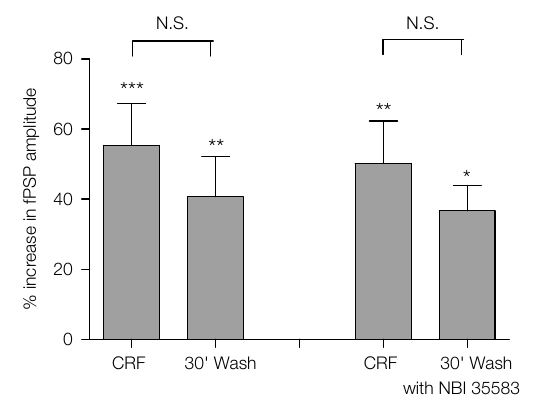
Figure 6 | Comparison of the increase in fPSP amplitude following appli- cation of CRF (0.1 μ M) and 30 min after wash-out of the peptide in the absence ( n = 7 slices from 5 rats) or presence of NBI35583 (1 μ M; n = 6 slices from 5 rats). Data shown are the mean ± SEM; * p < 0.05, ** p < 0.01, *** p < 0.001, N.S. not signifi cant, one-way repeated measures ANOVA fol- lowed by Bonferroni multiple comparison.